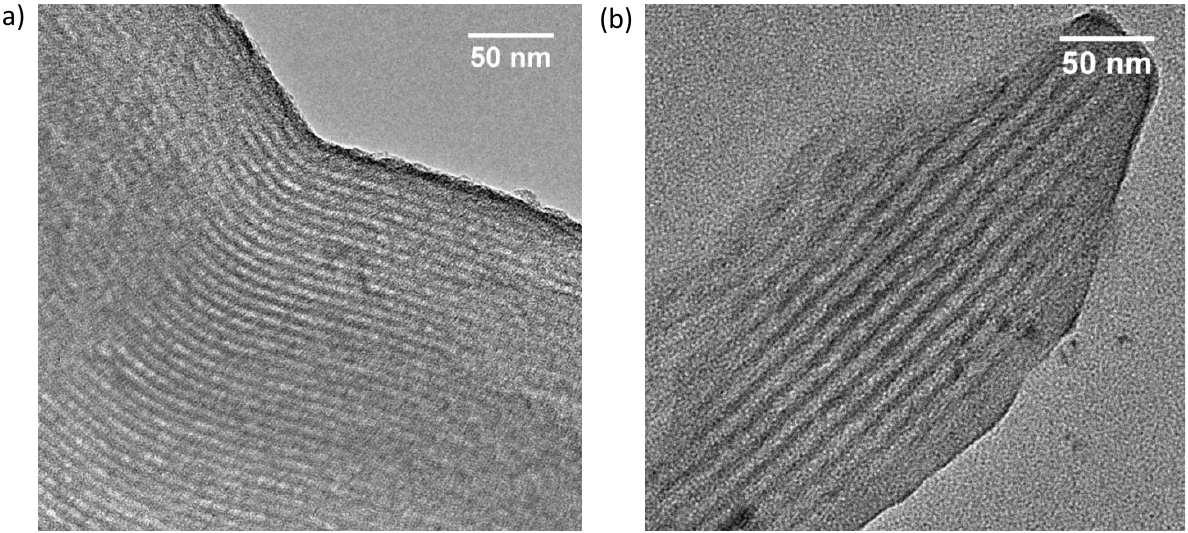
Figure 2. Powder X-ray diffraction patterns of CMK-3 (a) and SMC (b).